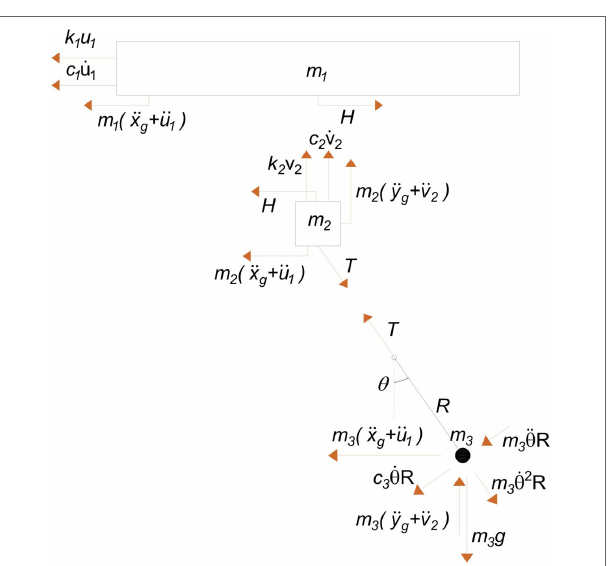
FigUre 3 | Free-body diagrams of the considered 3 degrees of freedom system. The vertical reactions acting on the crane are transferred directly to the supporting columns.